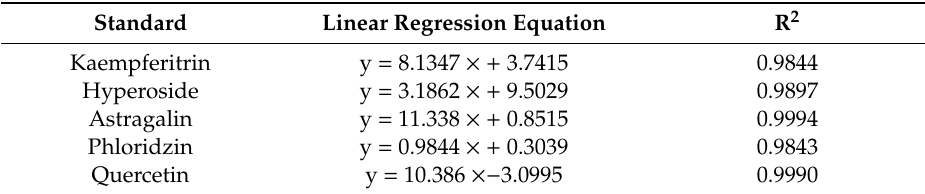
Table 3. Linear regression equation of standard product.